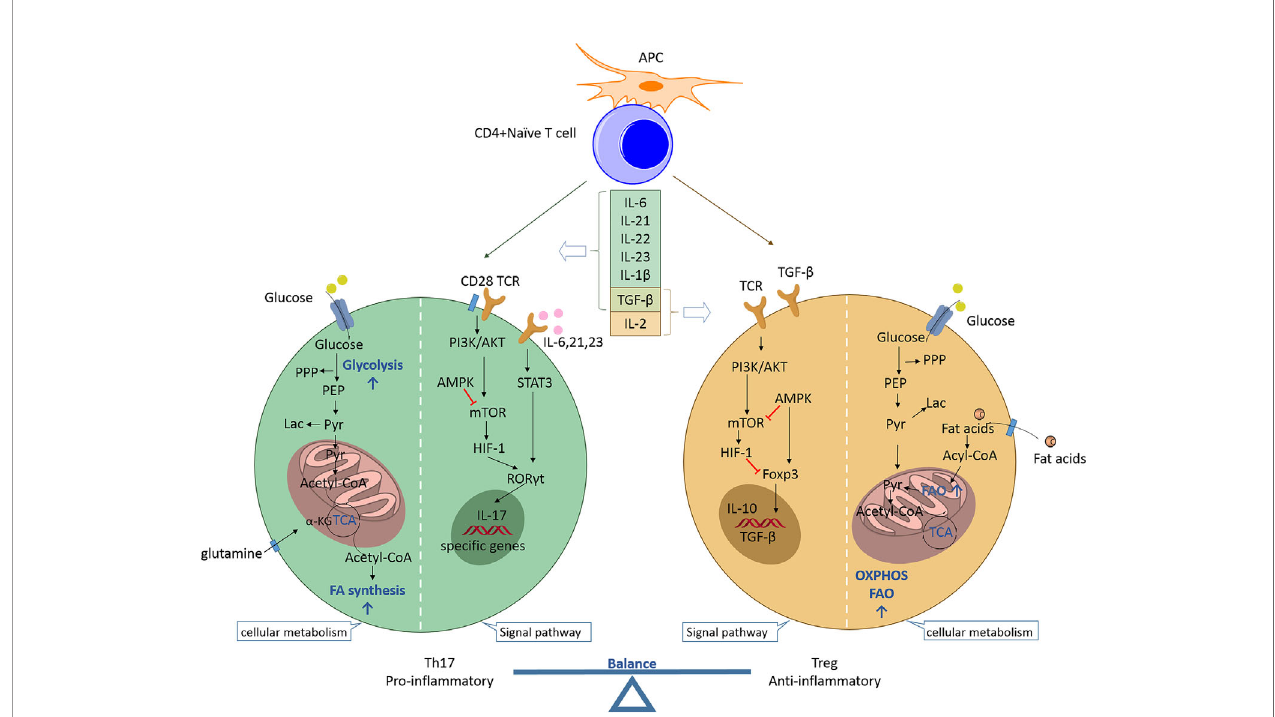
FIGURE 1 | Th17/Treg balance regulated by the cytokine microenvironment and cellular metabolic signaling pathways. Naïve CD4+ T cells may differentiate into T helper cells (proin fl ammatory Th17 or anti-in fl ammatory Treg cells) according to speci fi c cytokine pro fi les. Th17 cell differentiation can be induced by IL-6, IL-21, IL- 23, IL-1 b , and TGF- b . The proin fl ammatory cytokines IL-6, IL-21, and IL-23 activate STAT3 to induce RORC gene expression and stimulate T cells towards Th17 cell differentiation. ROR g t promotes the expression of speci fi c genes (e.g., CCR6 , CD161 , IL17a , IL17f , and IL23r ) to maintain the phenotype and function of Th17 cells. mTOR is activated by PI3K/Akt signaling after T cell receptor activation and co-stimulation along with naïve T cells. mTOR stimulates HIF-1 to support glycolysis and is indispensable for driving the Th17 phenotype. Additionally, the fatty acid biosynthetic pathway has been shown to regulate Th17 cell differentiation and function. The reverse is true for Treg cell differentiation. IL-2 and TGF- b promote Treg cell differentiation during the development of Treg cells, for which Foxp3 is indispensable. AMPK inhibits mTOR activity and promotes Foxp3-induced OXPHOS and FAO, which allow Treg cells to produce ATP and to generate energy. TGF- b is a developmental factor shared by Th17 and Treg cells and its function is dependent on the coexisting cytokines. Th17, T helper 17; Treg, regulatory T; APC, antigen-presenting cell; IL, interleukin; TGF, transforming growth factor; TCR, T cell receptor; PPP, pentose phosphate pathway; PEP, phosphoenolpyruvate; Lac, lactate; Pyr, pyruvate; a -KG, alpha ketoglutarate; TCA, tricarboxylic acid; FA, fatty acid; PI3K, phosphatidylinositol 3-kinase; Akt, protein kinase B; STAT3, signal transducer and activator of transcription 3; ROR g t, retinoid acid-related orphan receptor g t; mTOR, mammalian target of rapamycin; HIF-1, hypoxia inducible factor 1; Foxp3, forkhead box protein P3; AMPK, AMP-activated protein kinase; OXPHOS, oxidative phosphorylation; FAO, fatty acid